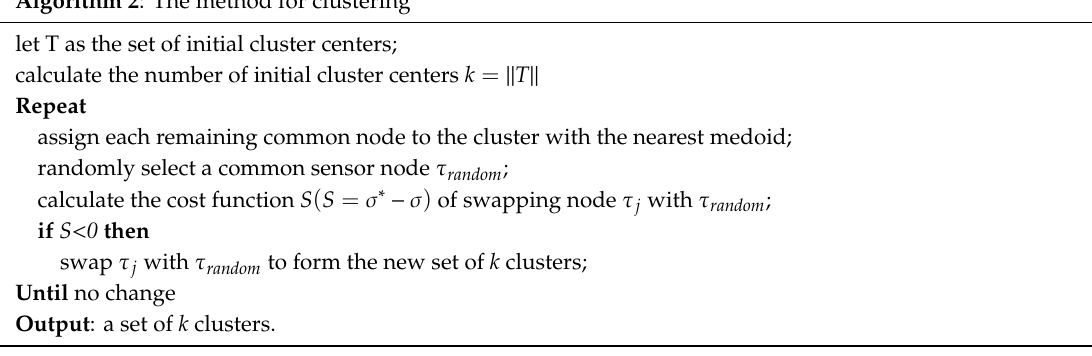
Algorithm 2 : The method for